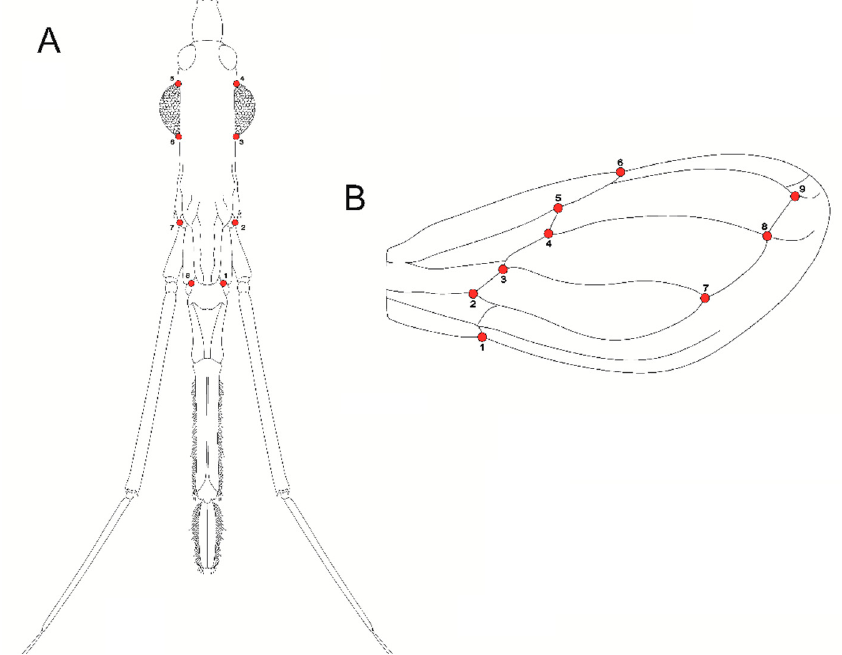
Figure 2. Graphical representation of the landmark positions in head and wing of Triatoma infestans . ( A ) Head dorsal view; ( B ) wing view.